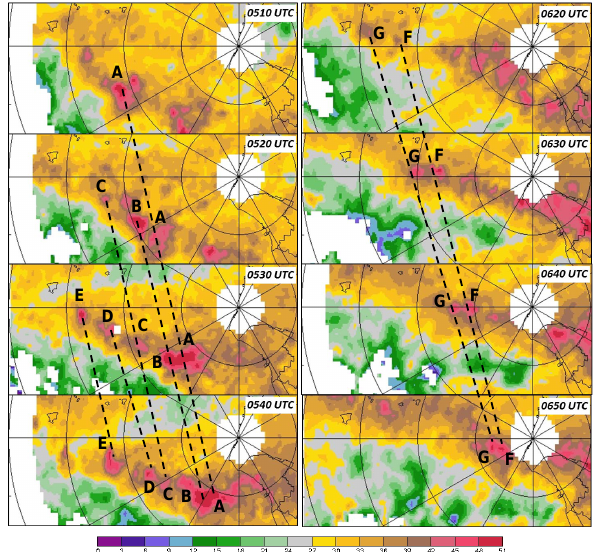
Figure 4. Series of CAPPI reflectivity (dBZ, scale at bottom) at 3km observed by the Chigu radar (cf. Fig. 3 for location) every 10min during 05:10–05:40 and 06:20–06:50UTC, 8 August 2009, for regions of 100 × 45km 2 covering the E–W oriented rainbands (courtesy of C.-H. Liu). The concentric rings are 20km apart. Se- lected back-building cells are labeled as A–G and cell motions are marked (dashed